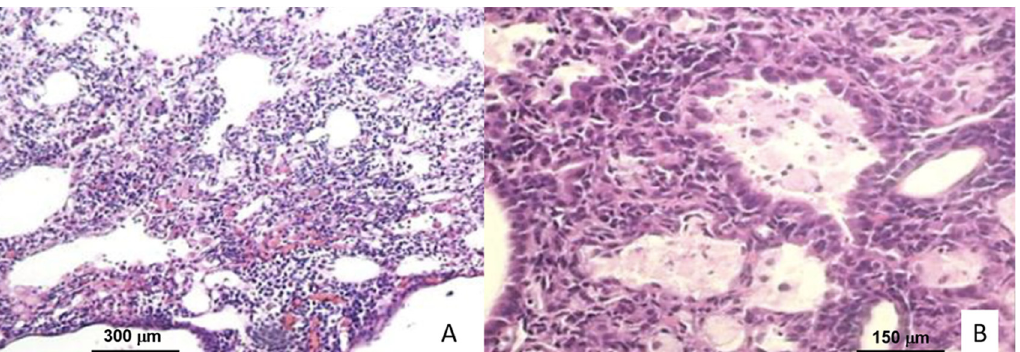
Figure 1. Histological micrographs of Balb/C mice lung after 28 days of infection with M. tuberculosis H37Rv. ( A ) Extensive inflammatory infiltrates, granulomas, and pneumonic areas (40× magnifica- tion). ( B ) Foamy and epithelioid cells (400× magnification).